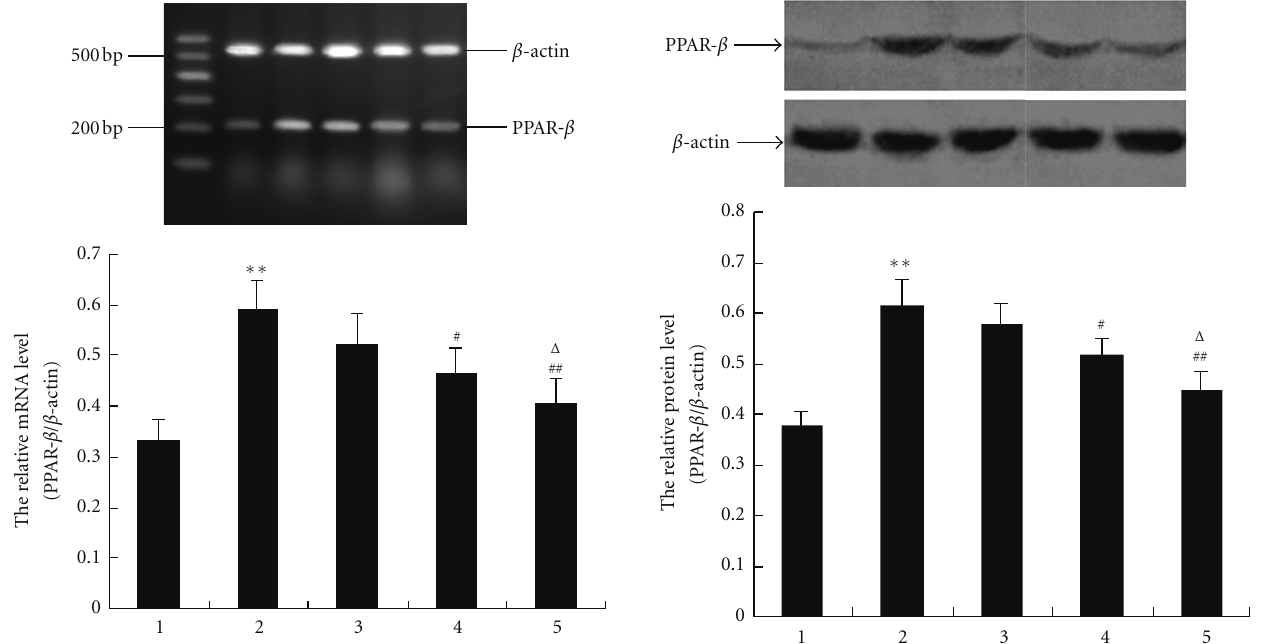
Figure 4: GW0742 inhibits protein expression of PPAR- β in hip- pocampus of rats after GCIRI ( n = 4). The relative protein level of PPAR- β was normalized to endogenous β -actin protein for each sample. 1: vehicle sham group, 2: vehicle model group, 3: GW0742 20 model group, 4: GW0742 60 model group, and 5: GW0742 180 model group. Dates are expressed as mean ± SD of four individual experiments. ∗∗ P < 0 . 01 compared with vehicle sham group; # P < 0 . 05, ## P < 0 . 01 compared with vehicle model group; Δ P < 0 . 05 compared with GW0742 20 model